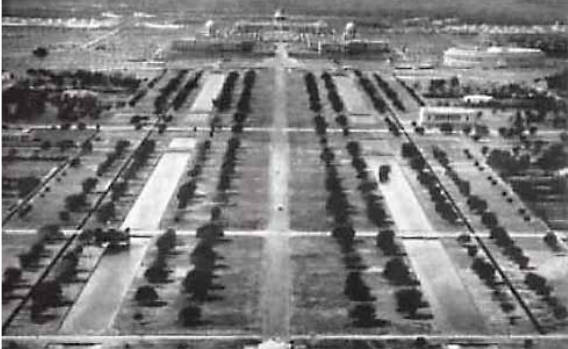
fig. 14. lutyens’ rational urbanism – the order of urban forms in the Delhi complex (Von Moos 2007)